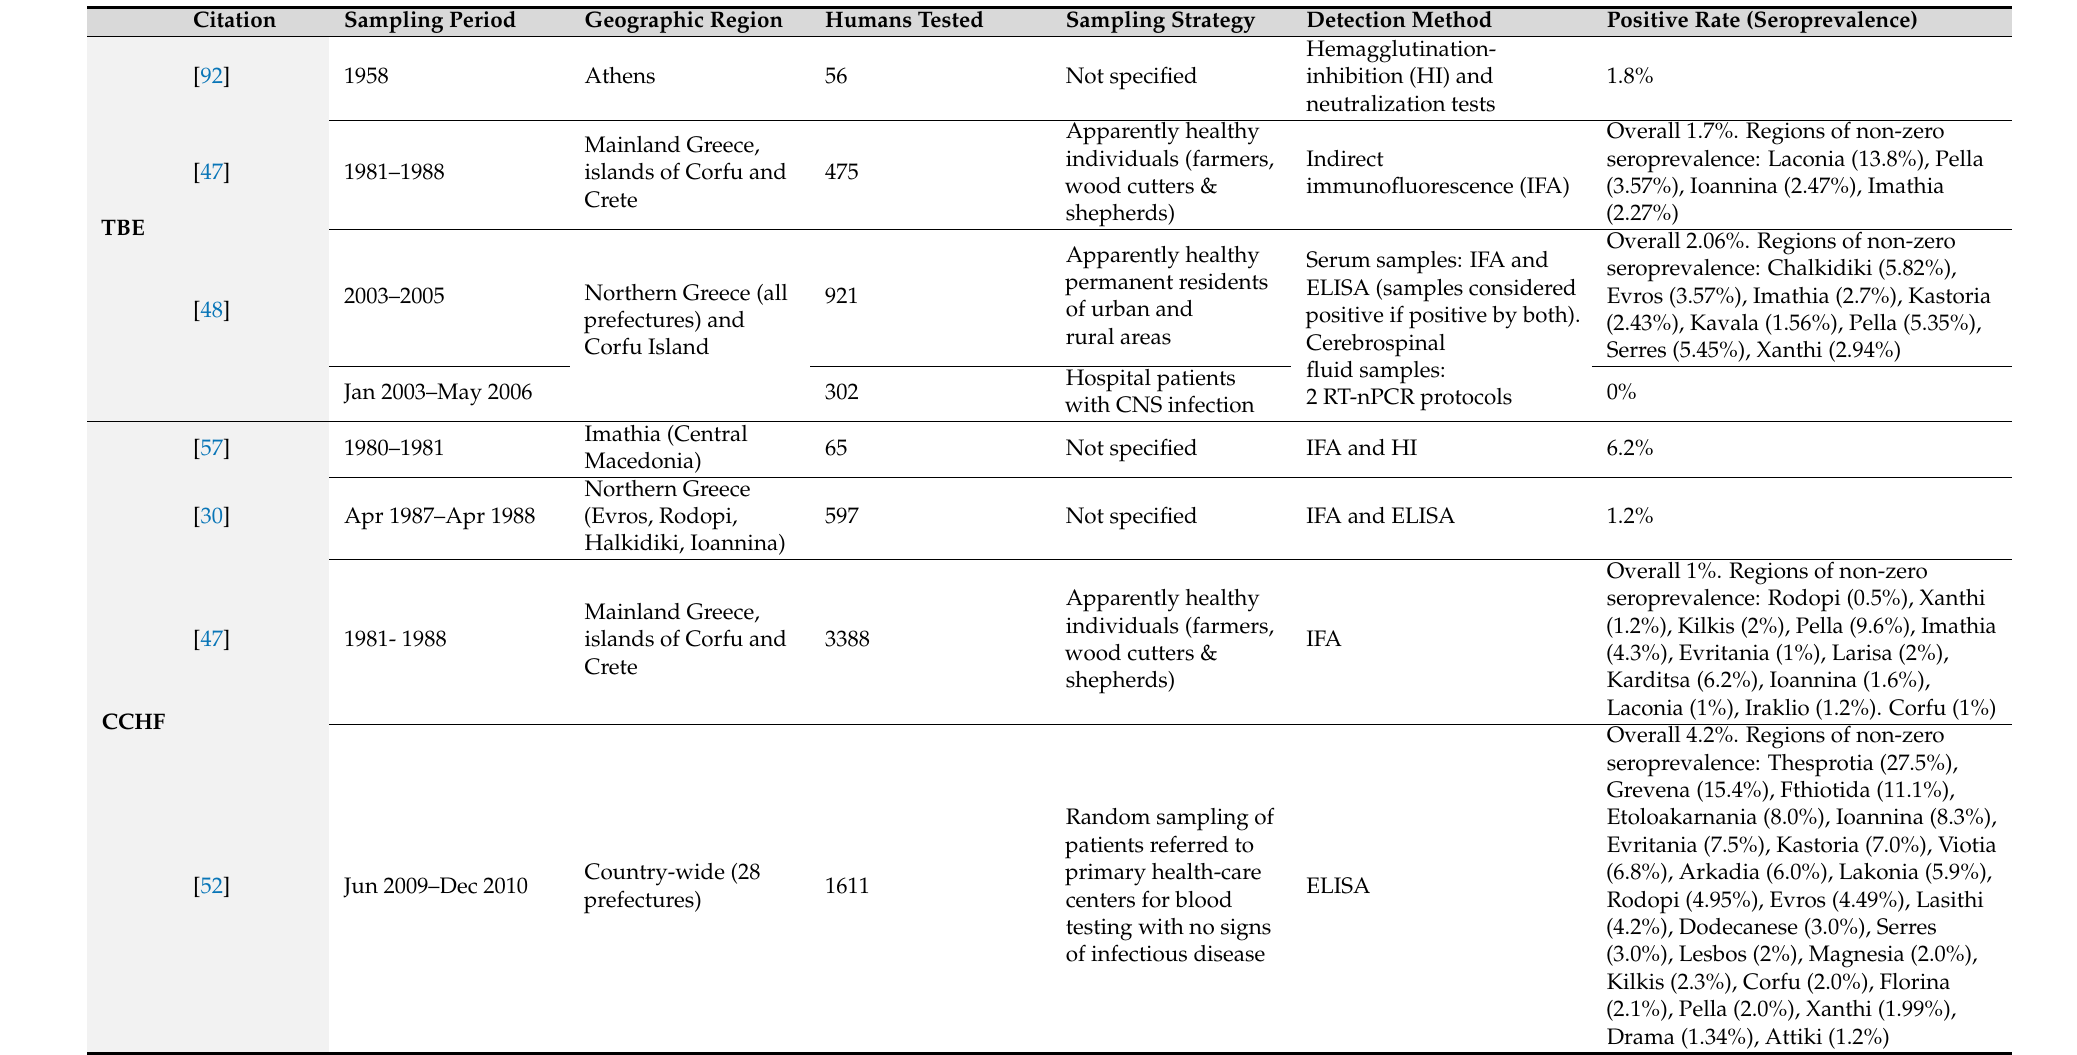
Table 4. Summary of the key findings of published studies on the seroprevalence of TBDs in humans in